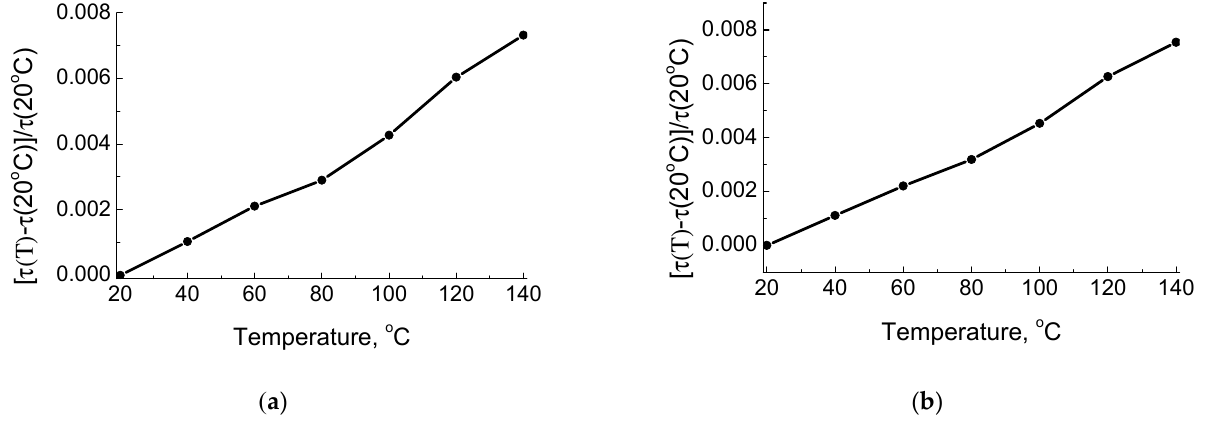
Figure 4. Relative delay time as a function of substrate temperature: ( a ) for the SAW propagation along the X + 70°-axis and ( b ) for the pseudo-surface wave propagation along the X-axis on the Z-cut of KTP.